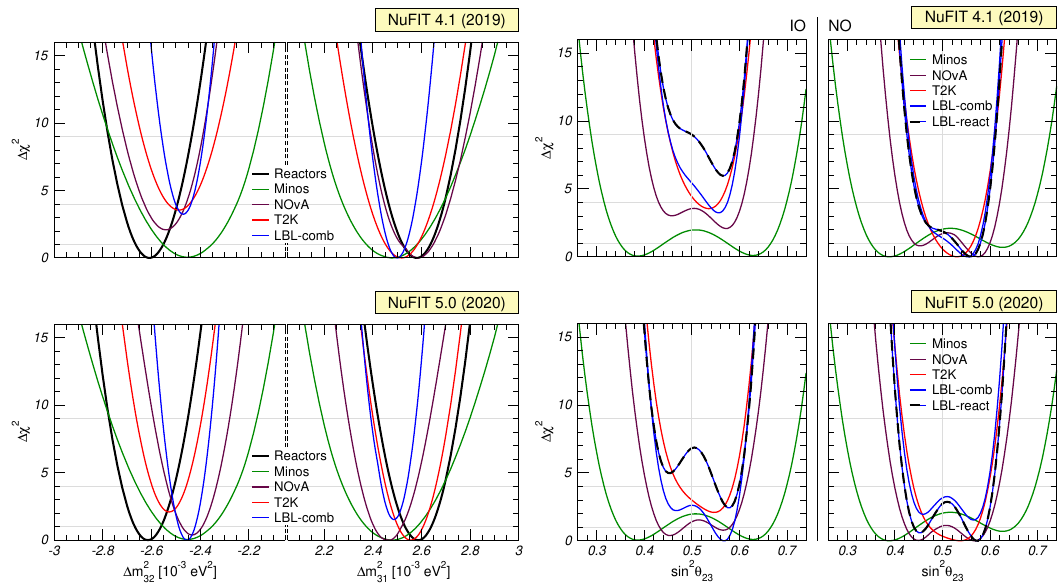
Figure 4 . (cid:1) (cid:31) 2 pro(cid:12)les as a function of (cid:1) m 2 (left) and sin 2 (cid:18) 23 (right) for di(cid:11)erent LBL data 3 ‘ sets and their combination. In the left 4 panels we show also the combined reactor data from Daya-Bay, RENO and Double-Chooz. For all curves we have (cid:12)xed sin 2 (cid:18) 13 = 0 : 0224 as well as the solar parameters and minimized with respect to the other un-displayed parameters. (cid:1) (cid:31) 2 is shown with respect to the best (cid:12)t mass ordering for each curve. Upper panels are for the NuFIT 4.1 data set, whereas lower panels correspond to the current